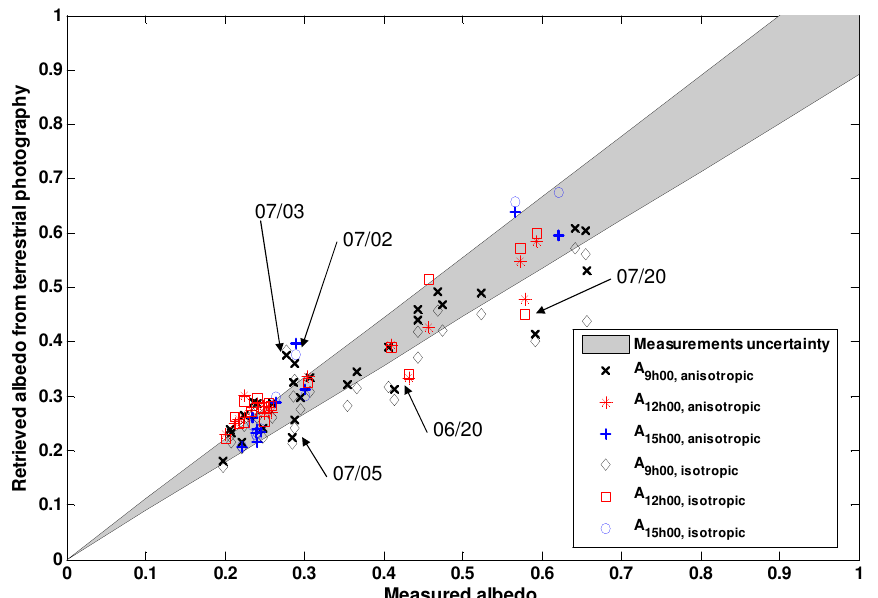
Fig. 6. Comparison between the albedo retrieved from terrestrial photography and the albedo measured by the AWS during the summer 2009. The gray area depicts the uncertainties of albedo measurements ( ± 10%). The squares and the circles correspond to the albedo estimated from the photographs while ignoring the anisotropic reflectance of snow and ice. The dots and crosses show the albedo estimated while modelling the anisotropy.